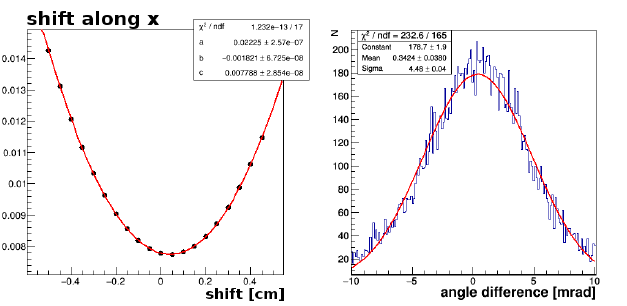
Figure 1. Left: Determination of the shift of the HEX drift chamber with respect to D1D2 drift chamber. Right: Estimation of the current track resolution (explanation given in the